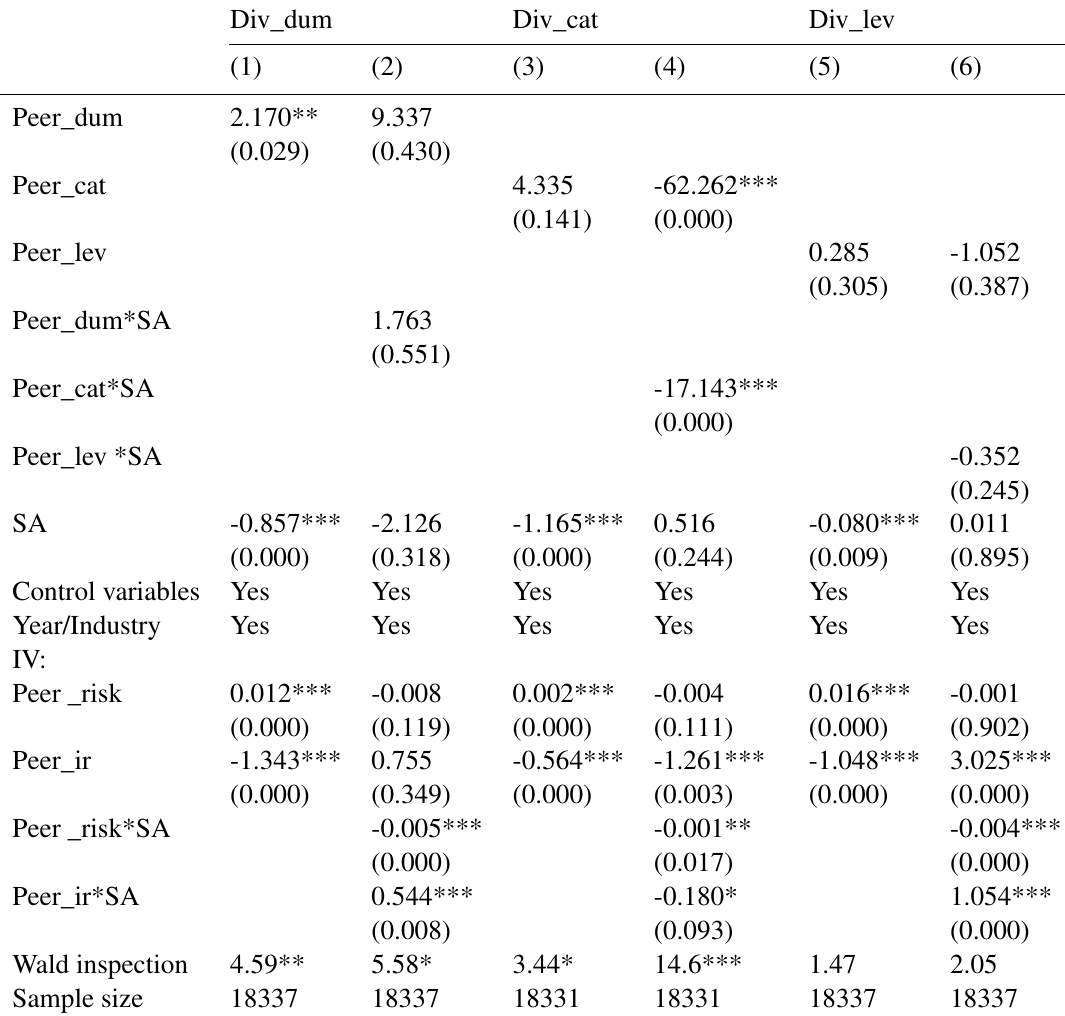
Table 7 Robustness test of